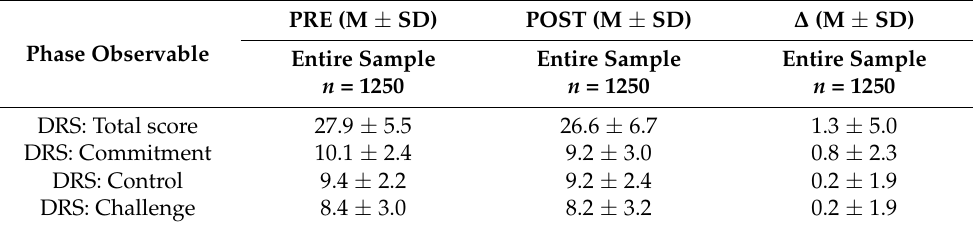
Table 3. DRS total, commitment, control, and challenge scores reported as mean and standard deviation for the entire